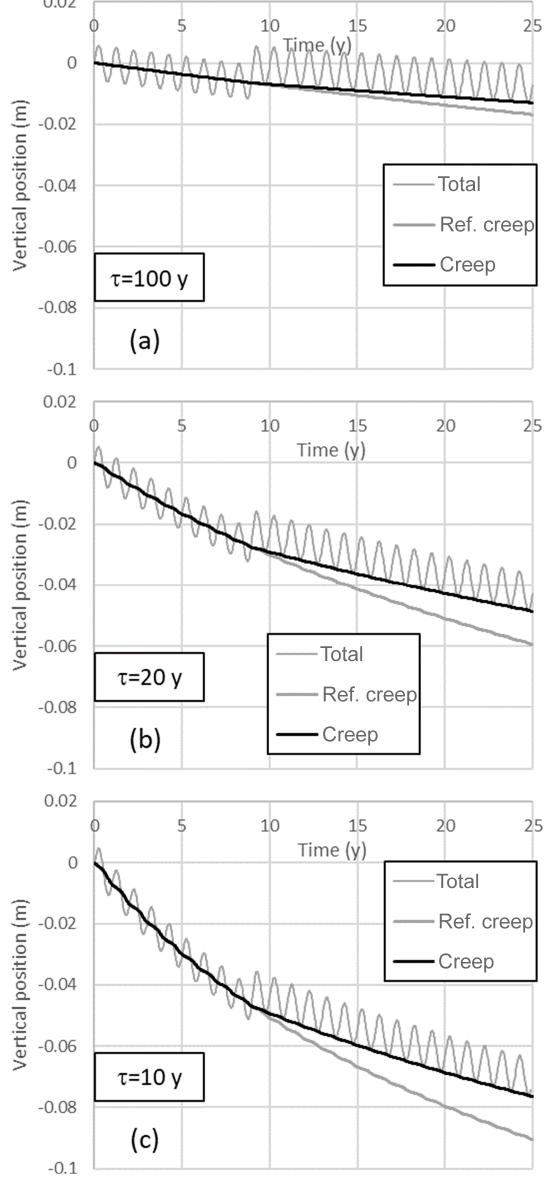
Figure 4. Calculated subsidence for scenario “damping”. The creep of the reference runs is depicted as “ref. creep”.